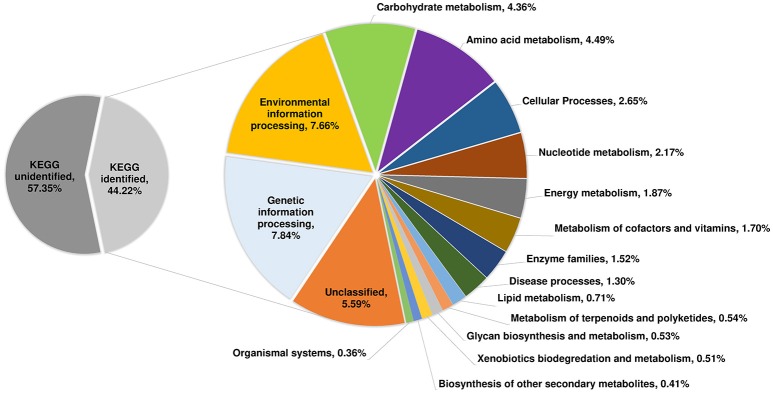
Proteome analysis for 44 C. difficile RT014 genomes. Functional proteomic characterization of CDS identified in the C. difficile RT014 pan-genome (n = 44). A total of 3355 CDS (44.22%) were classified by KEGG. CDS categorized as “unclassified” were identified by but no functional classification currently exists.